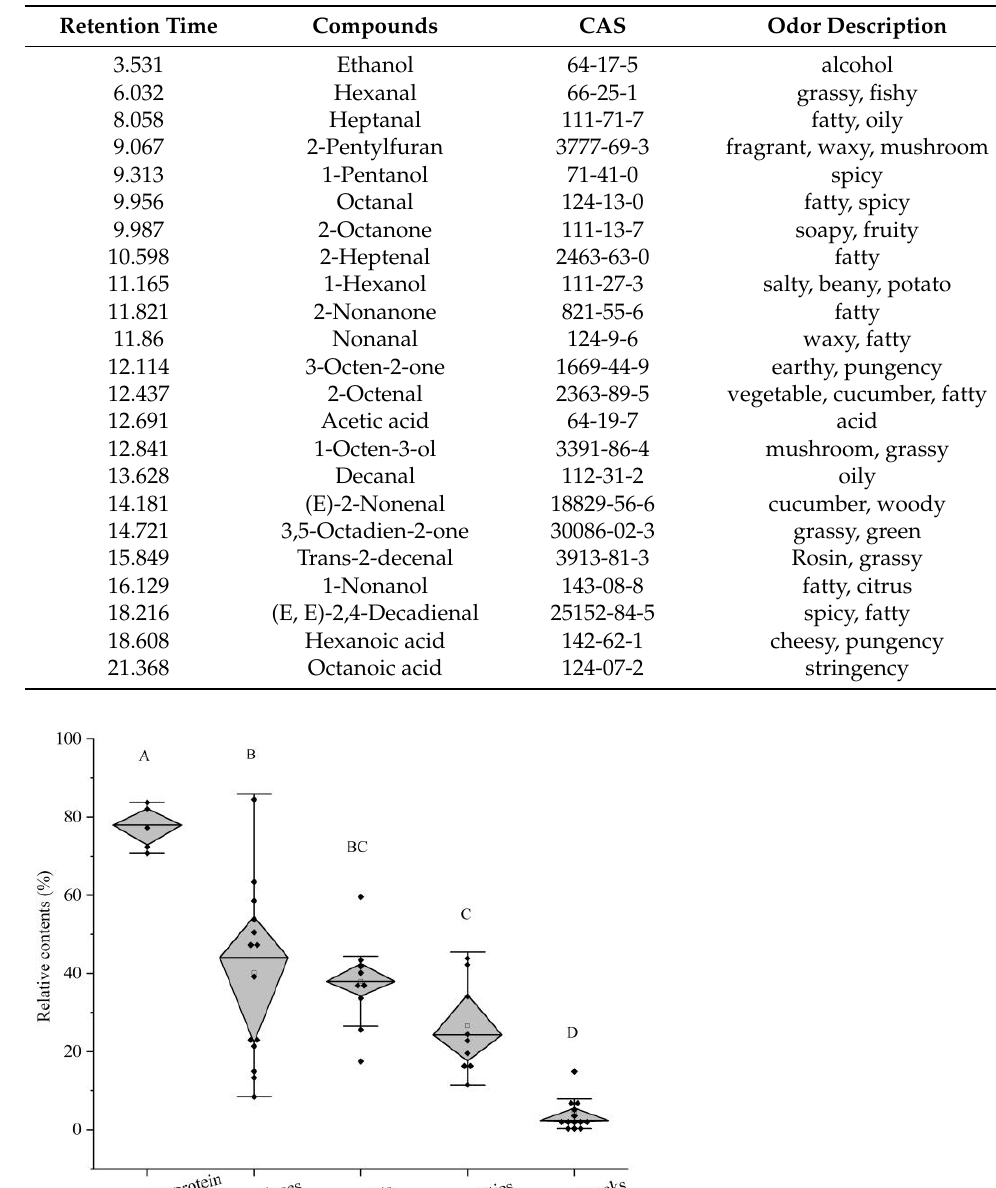
Table 1. Off-flavor volatile compounds in commercial products.